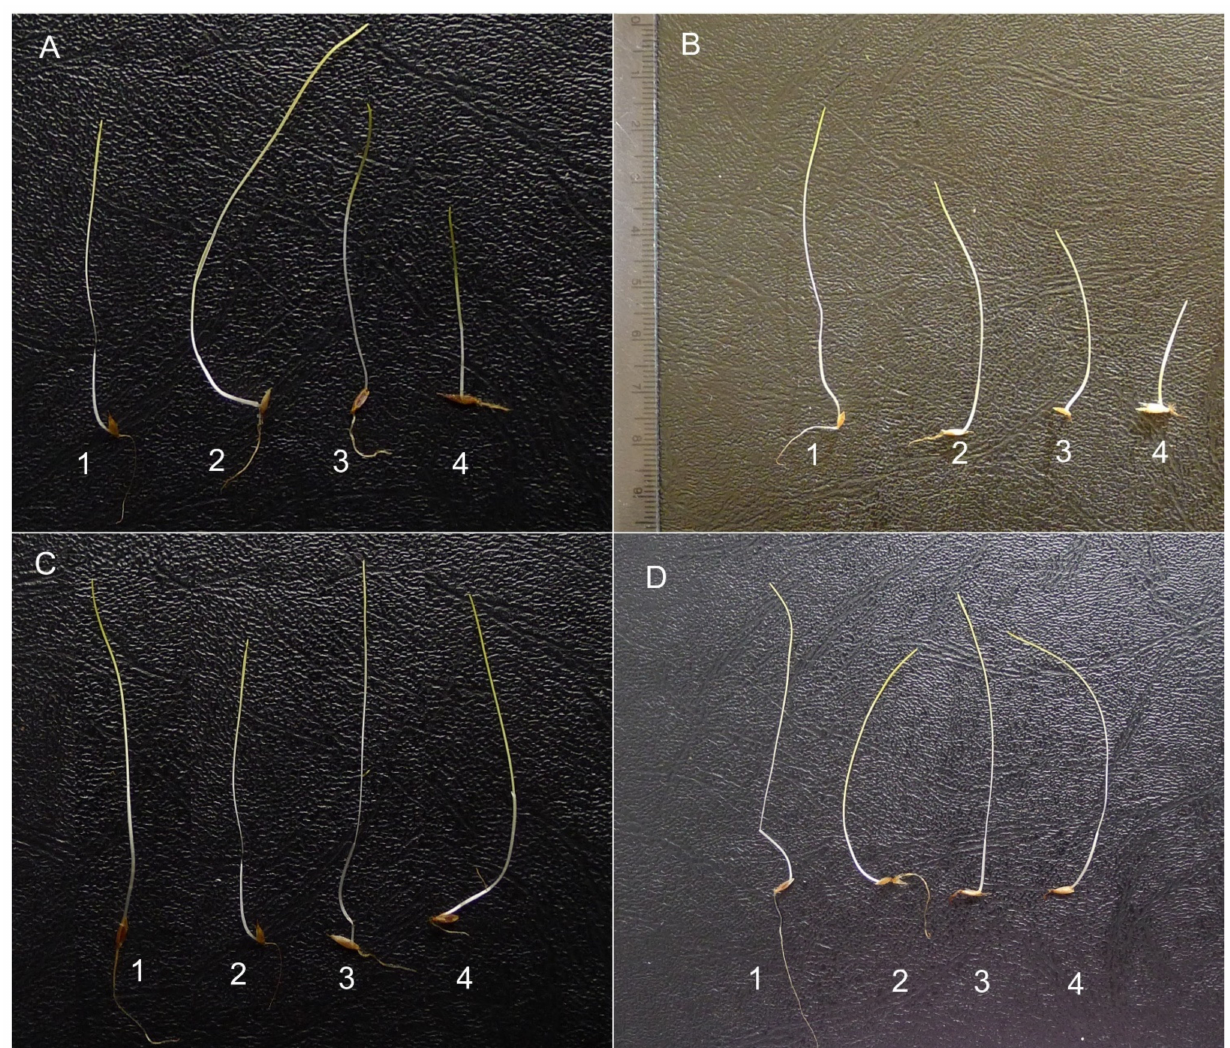
Figure 4. Seedlings of Festuca rubra L. grown on aqueous extracts from the organs of Rosa blanda Aiton at various percentage concentrations (1%, 2.5%, and 5%); organs: ( A )—flower, ( B )—leaf, ( C )—stalk, ( D )—root; 1—control (distilled water); the influence of the extracts was analyzed separately at three weekly intervals, hence, the different control view, 2—1% extract, 3—2.5% extract, 4—5% extract (Photo Beata